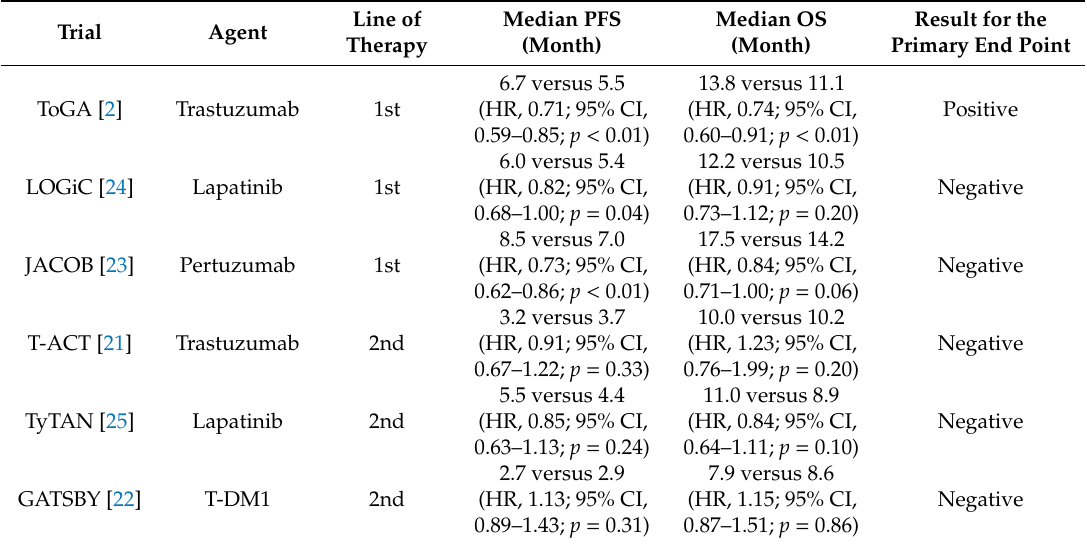
Table 1. Pivotal randomized phase II and III trials of human epidermal growth factor receptor